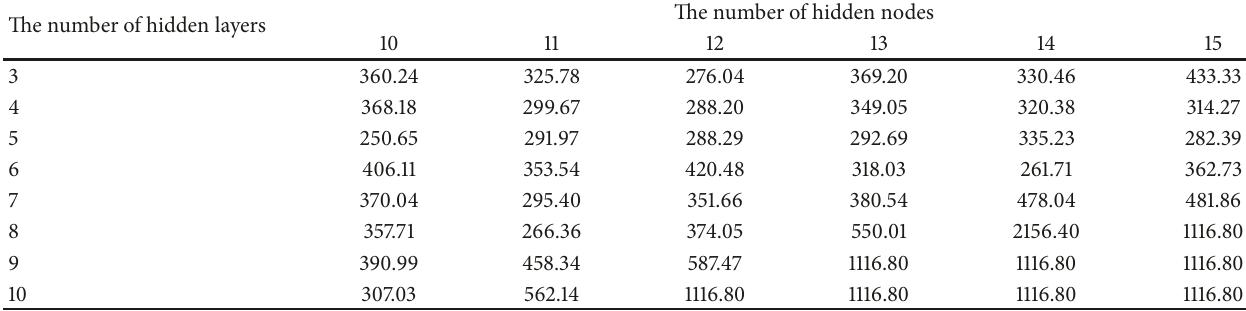
Table 2: The prediction error of MELM models with fixed network structure. The number of hidden layers